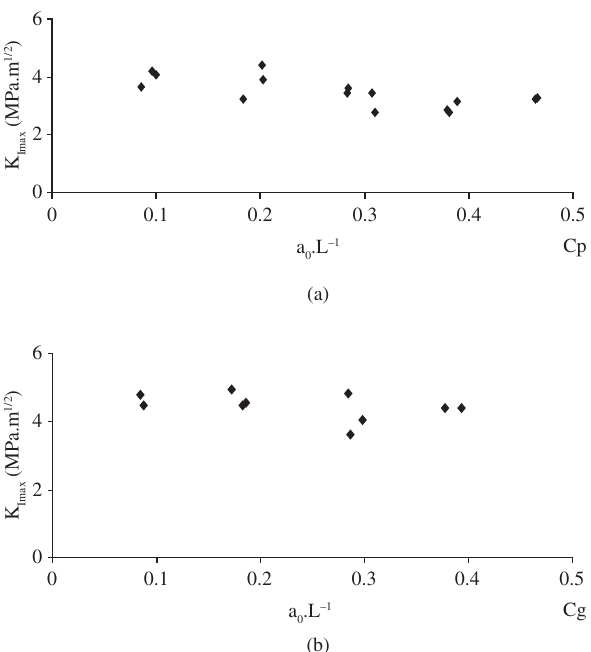
, versus a /L: a) small test Figure 4. Dispersion of the R-curves obtained by Lemaistre (1998) for dif- Imax 0 ferent castables. Here, a/W is equivalent to the a